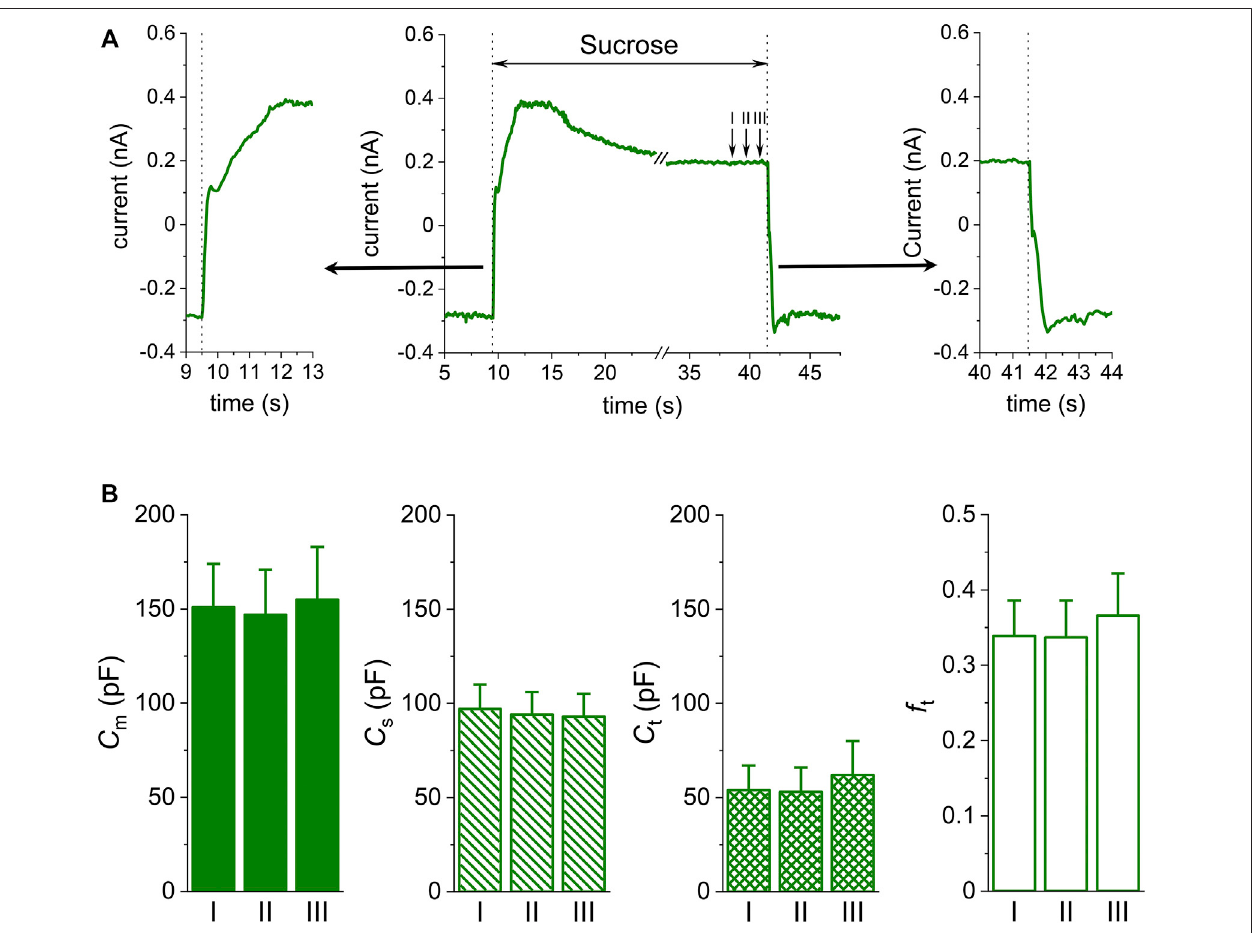
FIGURE 2 | Time course of the sucrose effect. (A) Changes of the membrane current at − 80 mV during application and subsequent wash-out of isotonic sucrose solutioninarepresentativecell(middlepanel,thetimeaxisisinterruptedattheintervalwhenthevoltage-rampprotocolwasapplied;leftandrightpanels — detailsof4 sof the recording shown in the middle panel at the time of start and end of sucrose application, respectively). (B) Average values of basic parameters evaluated in the presenceofsucroseatthesteady-stateinthreeindependentintervalsI,II,andIIIattheendofsucroseapplication( n =5, p > 0.05withinthesameparameter;forthe approximate position of the intervals I, II, and III, please see arrows in part (A)